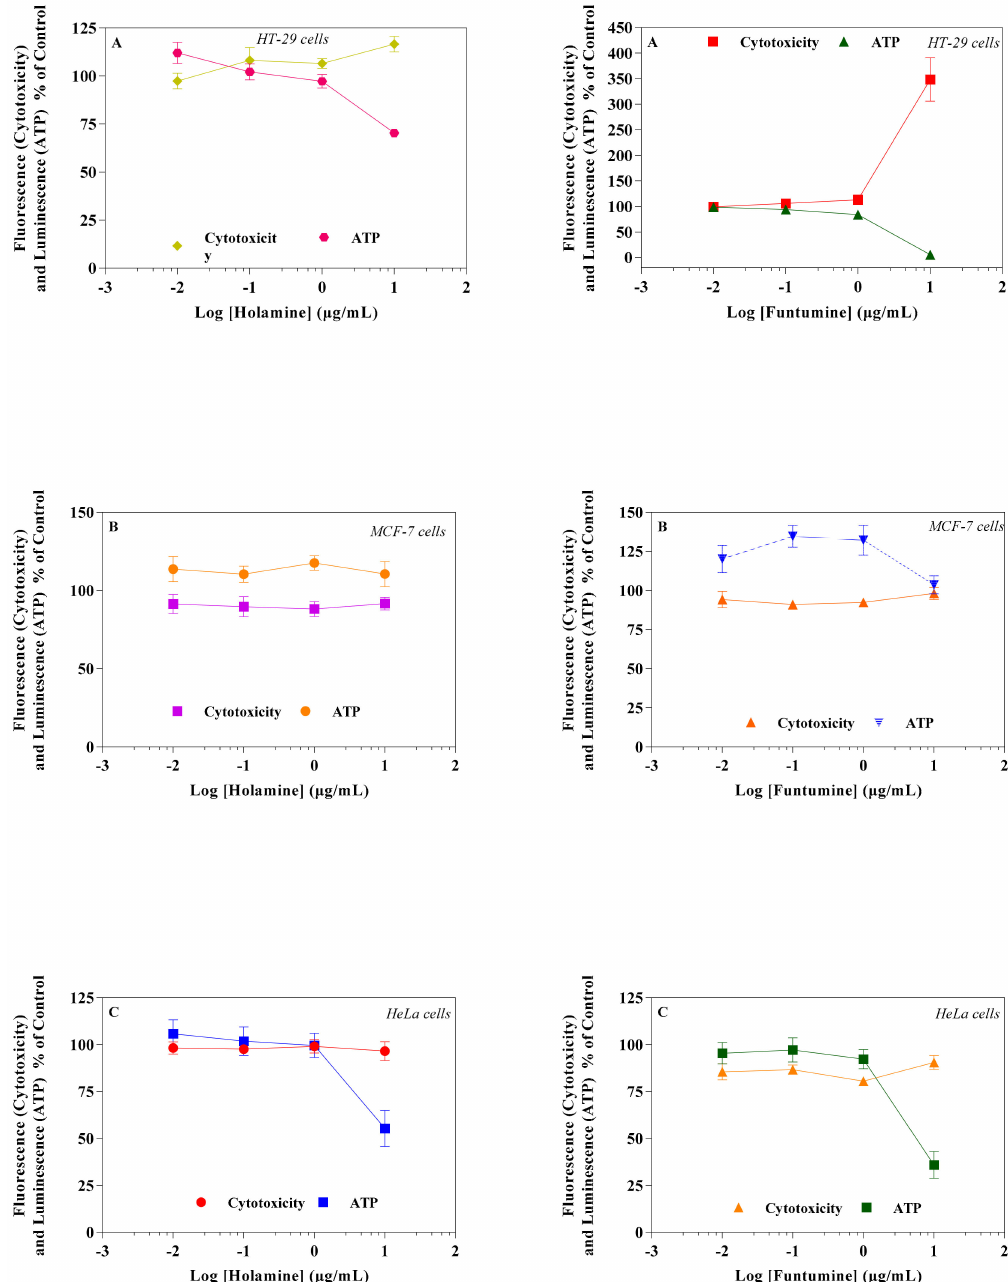
Figure 3. E ff ects of holamine and funtumine on mitochondrial function in HT-29I ( A ), MCF-7 ( B ), and HeLa ( C ) cancer cells. Cells were treated with increasing concentrations of the compounds for 2 h. Cytotoxicity and ATP production were measured by the MitoToxGlo ™ assay. Values represent the means ± SEM of quadruplicate